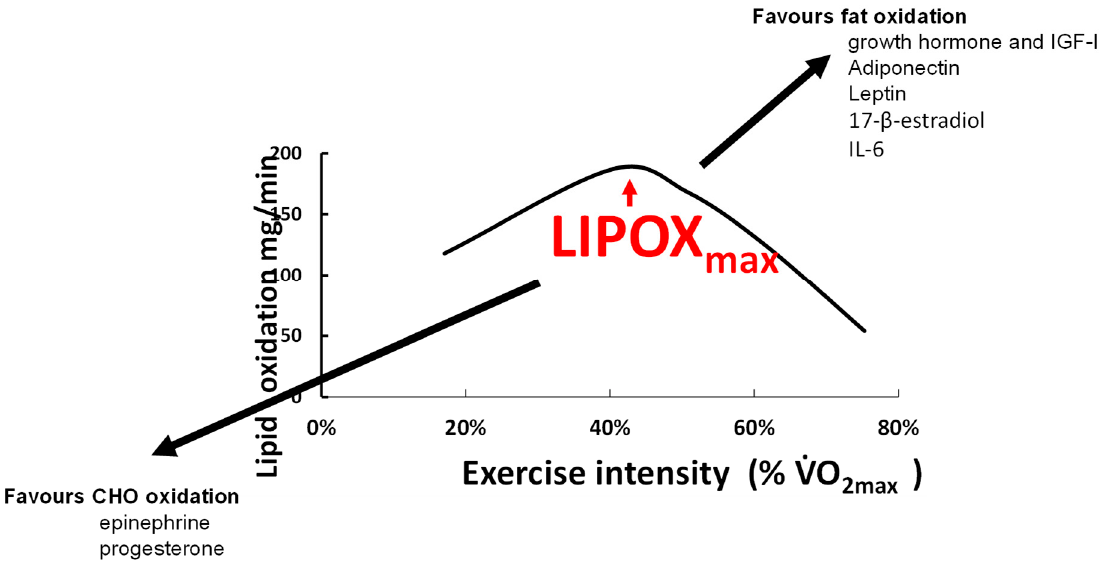
Figure 6. An attempt to summarize hormonal influences that shift the balance of substrates towards more carbohydrate vs. more fat oxidation. As indicated in the text, this issue remains poorly investigated.